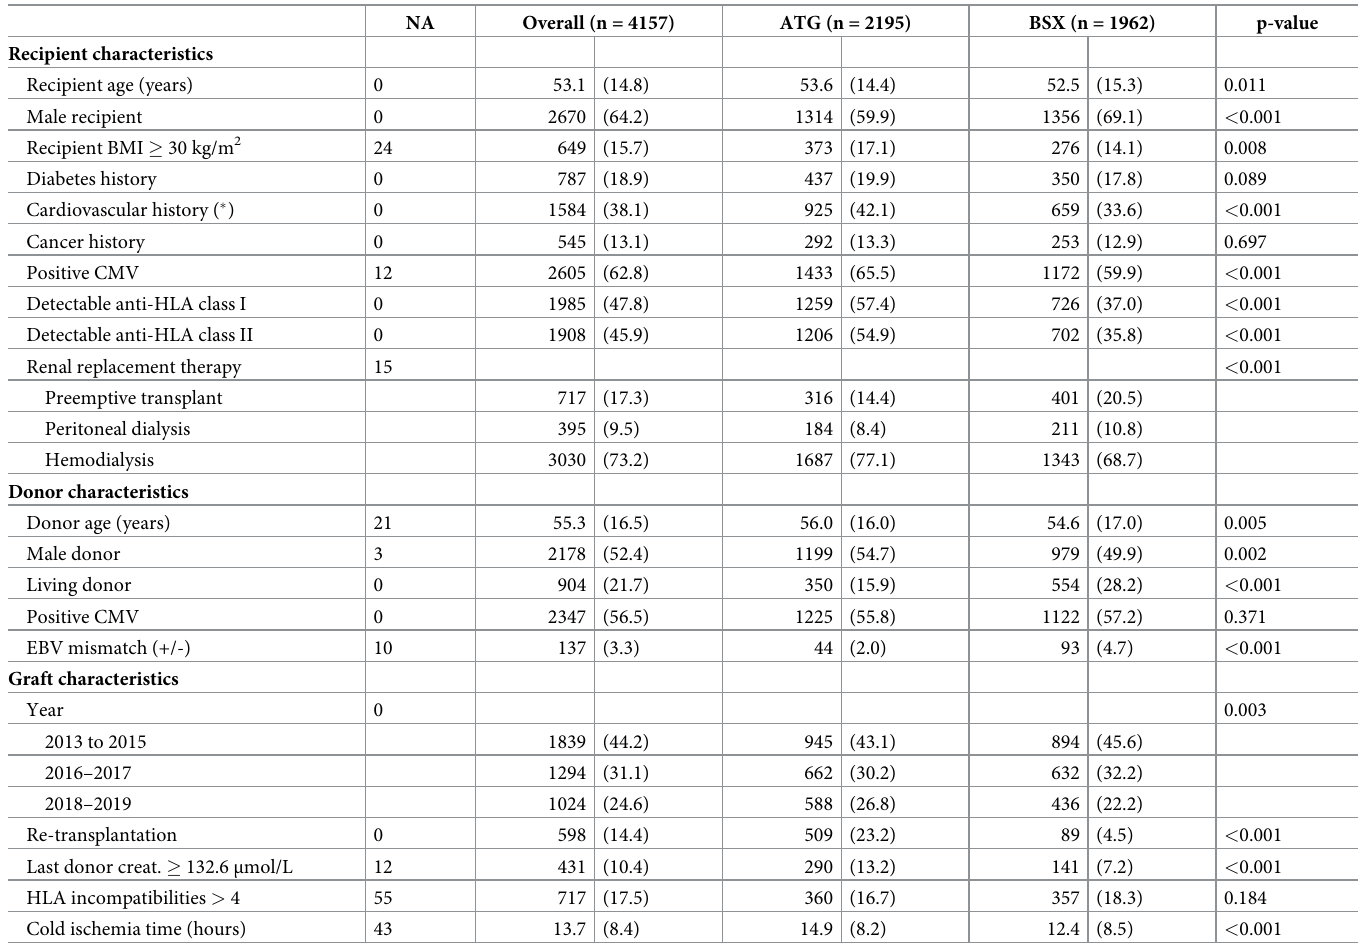
Table 2. Cohort characteristics according to induction